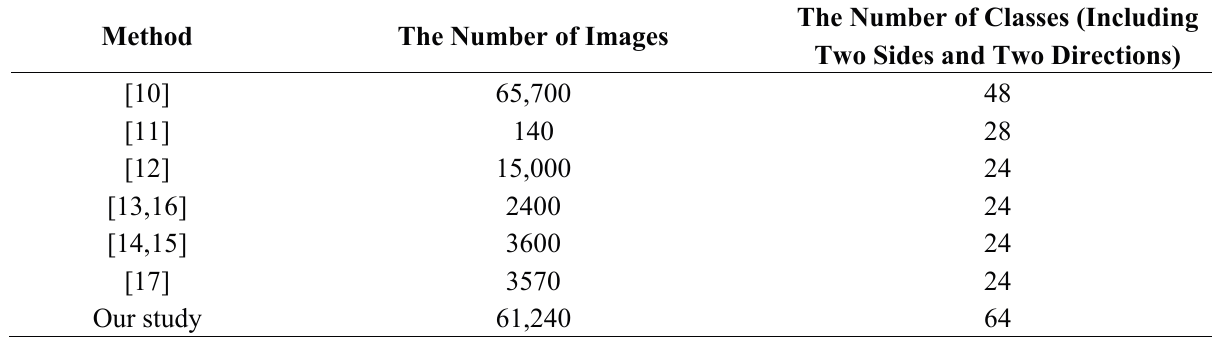
Table 2. Comparison of the number of images and classes used in previous studies with that of our